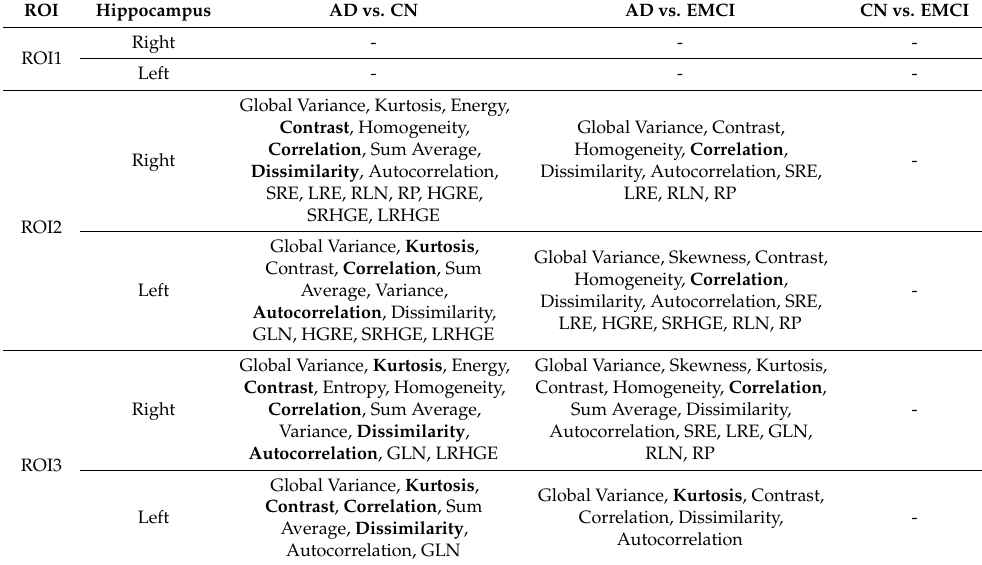
The subset of features highlighted in bold were also statistically significant when applying the Bonferroni